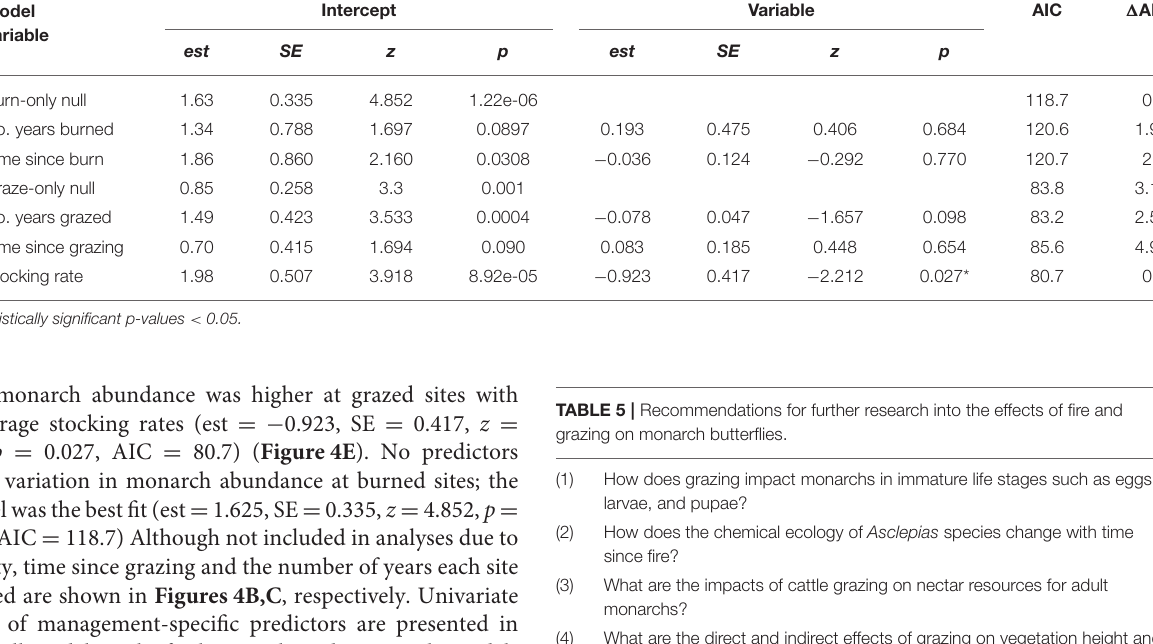
Table 4 . Full model results for burn-only and graze-only models can be found in Table S2 .